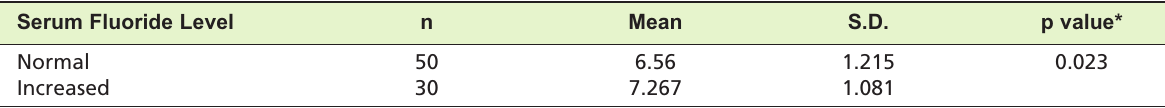
Comparison of VAS score with serum fluoride level. Table I: